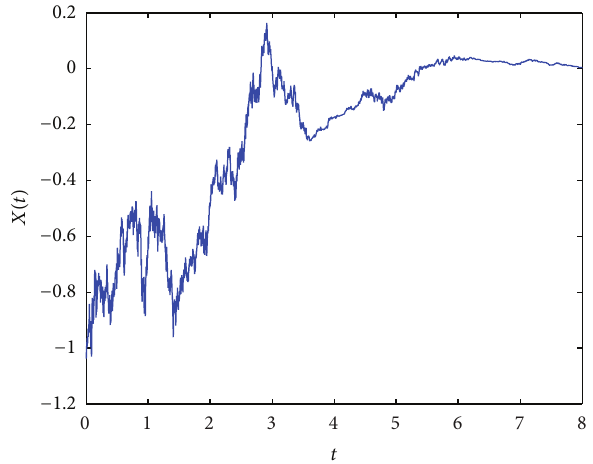
Figure 3: System without impulses for Example 2.